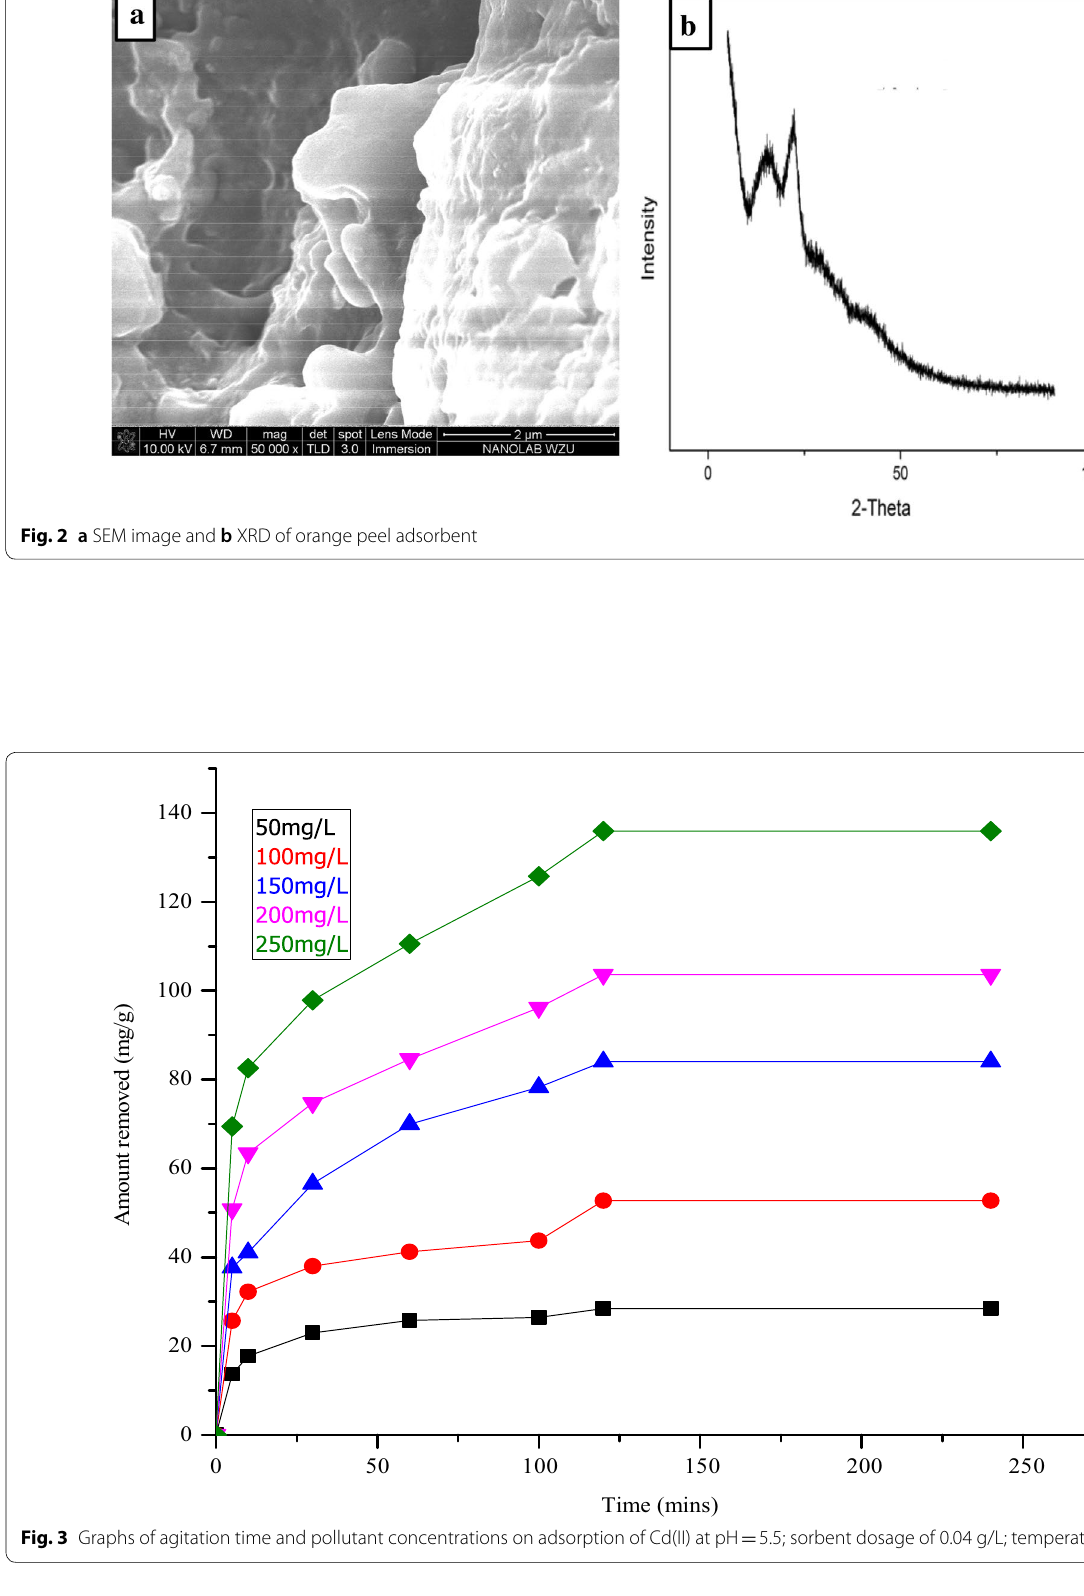
5.5; sorbent dosage of 0.04 g/L; temperature 45 =